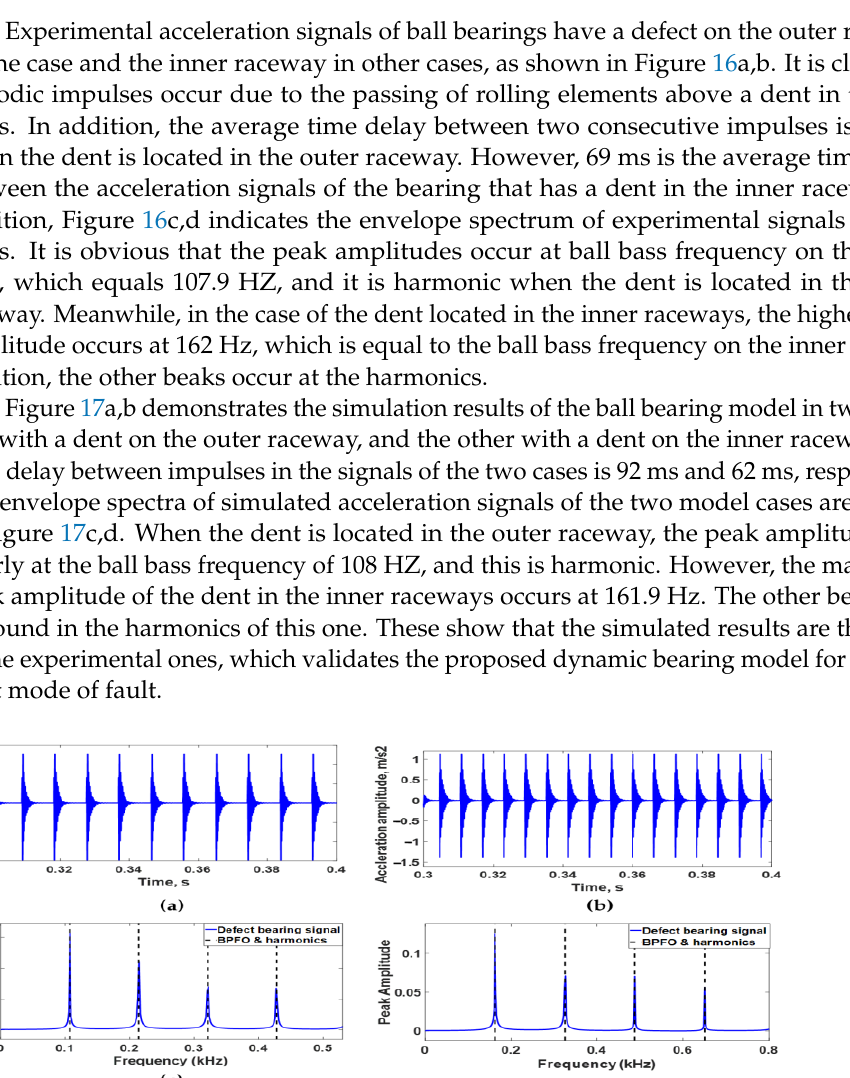
Figure 16. ( a ) Acceleration signal of experimental results of single defect on outer race, ( b ) acceleration signal of experimental results of single defect on inner raceway, ( c ) envelope spectrum of acceleration signal of experimental results of single defect on outer race, and ( d ) envelope spectrum of acceleration signal of experimental results of single defect on inner race.